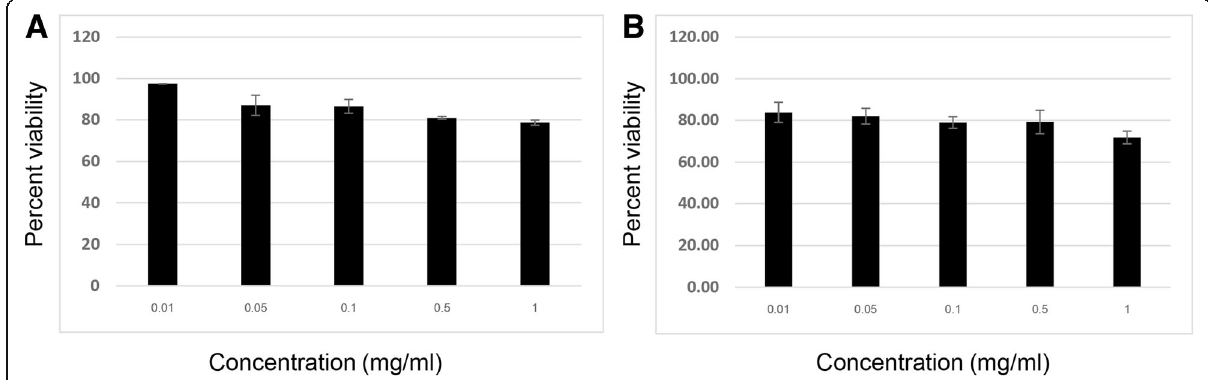
Fig. 2 Effect of NYEF ( a ) and NYWF ( b ) on the viability of HepG2 cells assessed by the MTT assay: Cells were treated with standard concentrations (0.01, 0.05, 0.1, 0.5 and 1 mg/ml) of NYEF and NYWF for 24 h. The results are expressed as the mean ± SD from three independent experiments. DMSO (0.5%) was used as the negative